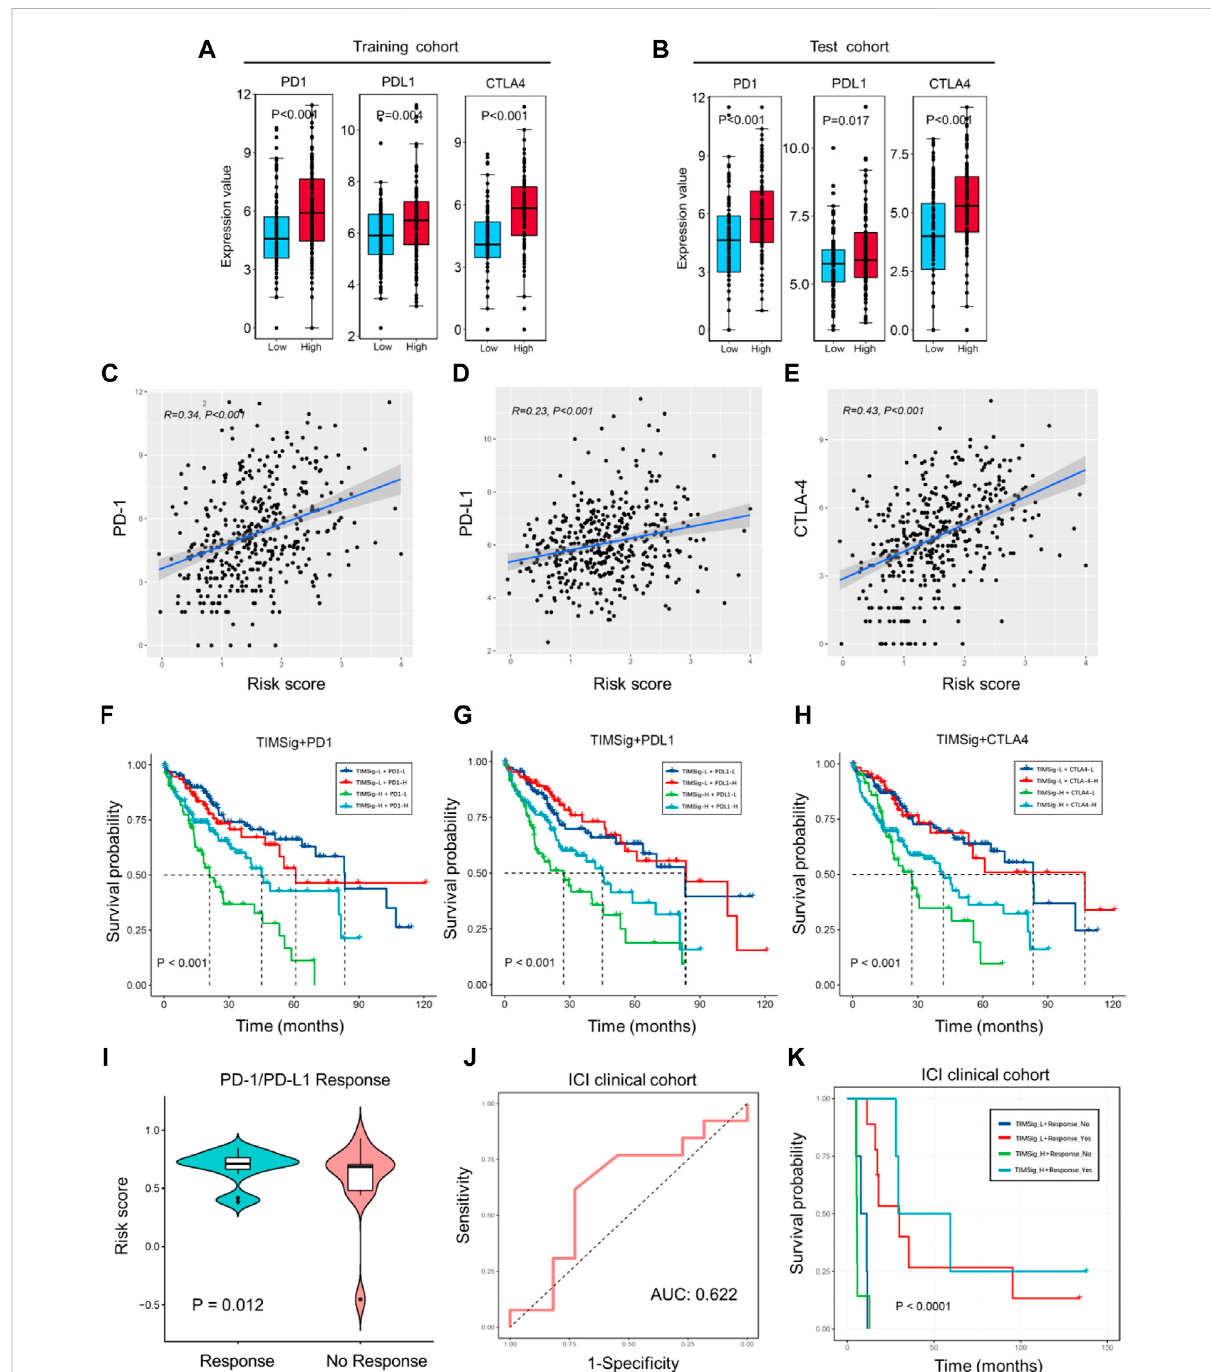
FIGURE 7 ImmunotherapyresponsewithTIMSig. (A,B) Comparisonoftheexpressionvalueofimmunecheckpoints(PD1,PDL1,andCTLA4)withdifferent groups of TIMSig in each cohort. (C – E) The Pearson correlation between immune checkpoints and the risk scores in the TCGA cohort. (F – H) K-M survival curves of OS among four patient groups strati fi ed by the TIMSig and PD1, PDL1, and CTLA4 in the TCGA cohort. (I) Comparison of the risk score with different groups of PD1/PDL1 therapy responses, paired t-test was used as the signi fi cance test. (J) The ROC curve to estimate the sensitivityofTIMSigtoPD1/PDL1therapyresponses. (K) K – MsurvivalcurvesofPFSamongfourpatientgroupsstrati fi edbytheTIMSigandPD1/PDL1 therapy